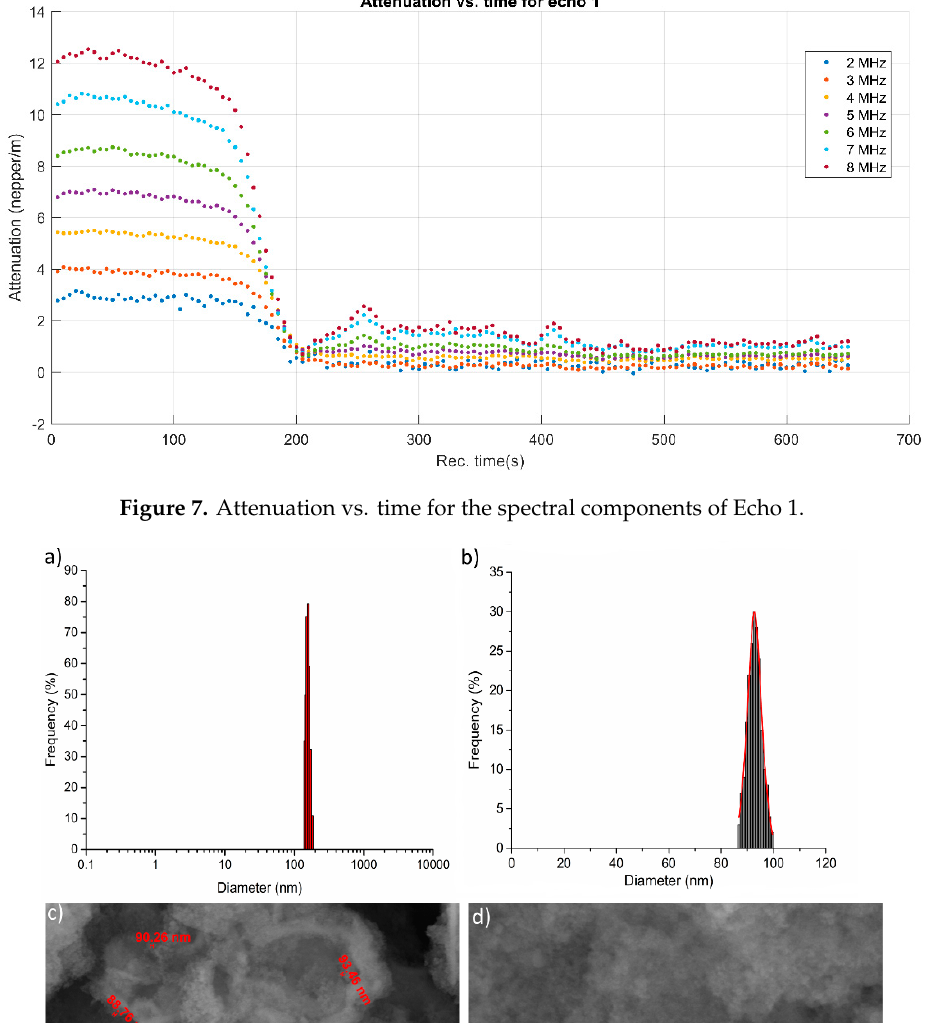
Figure 6. Attenuation vs. frequency for the first transmitted echo of the suspension (blue) and the reference fluid (red).